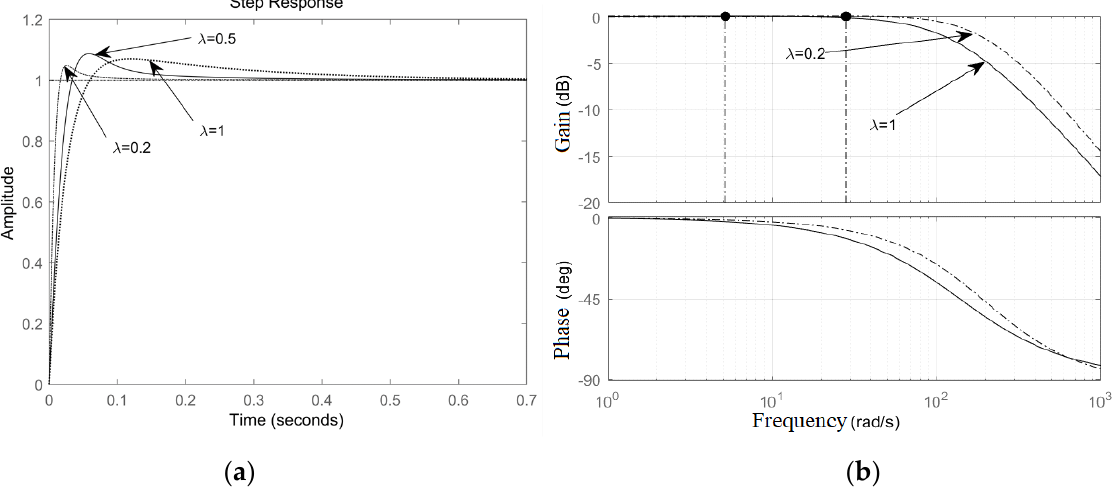
Figure 10. Step Responses for Different λ Values and Bode Plots: ( a ) step response with different λ ; ( b ) bode diagram with different λ .